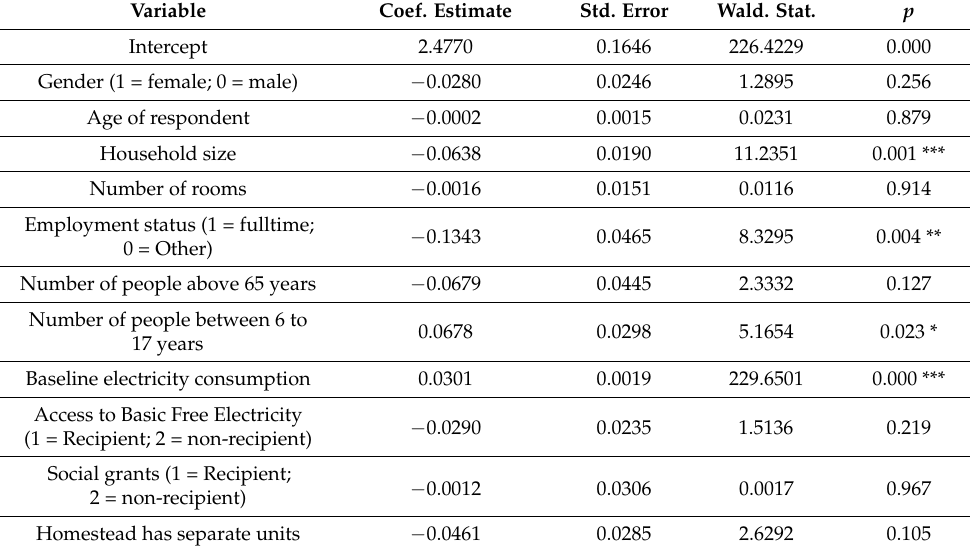
Table 4. Determinants of electricity consumption for FT